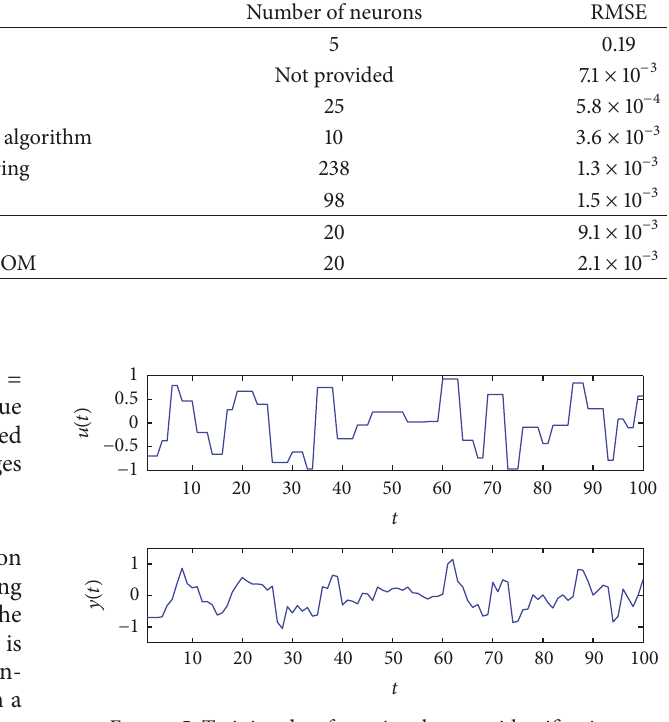
Figure 5: Training data for rational system